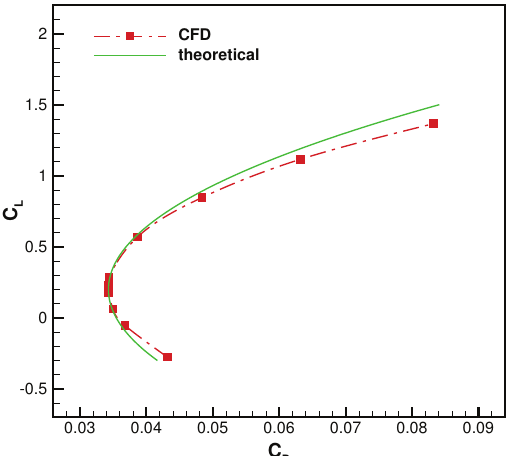
Figure 14. Clean configuration: drag